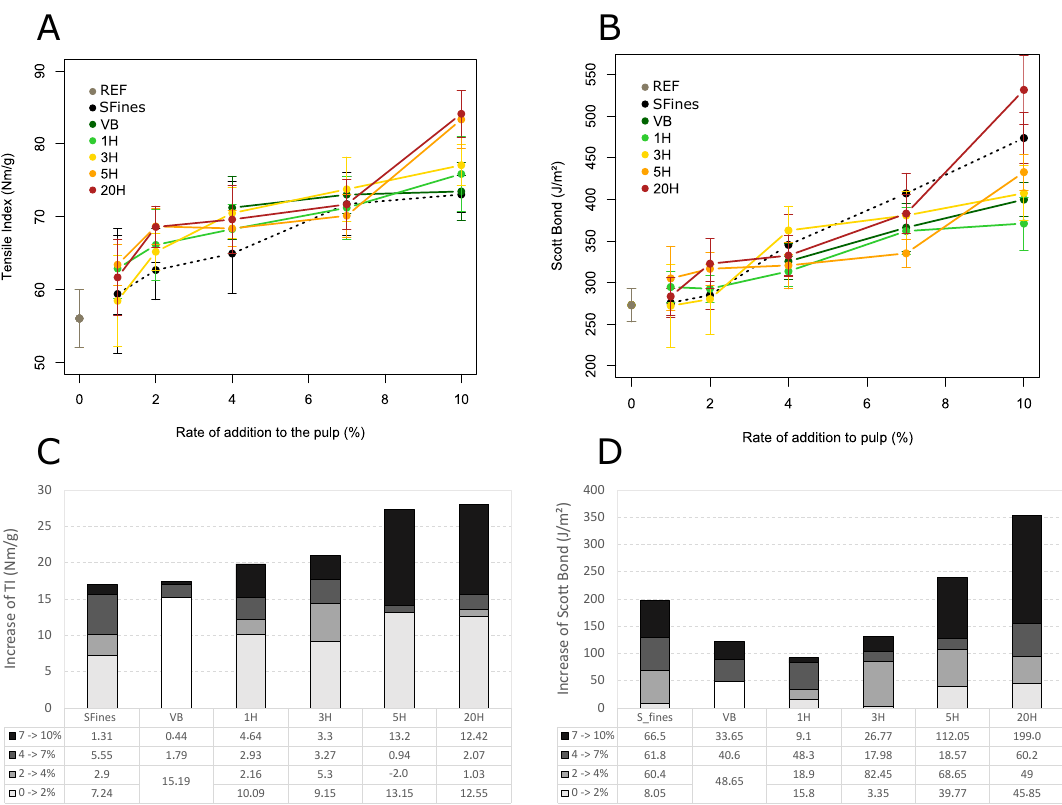
Figure 8. ( A ) Influence of the nature and quantity of the different fibrillated materials on tensile index (TI); ( B ) Influence of the nature and quantity of the different fibrillated materials on paper z-strength (Scott Bond); ( C ) Contribution of the partial increases of TI for each successive rate of addition ( D ) Contribution of the partial increases of Scott Bond for each successive rate of